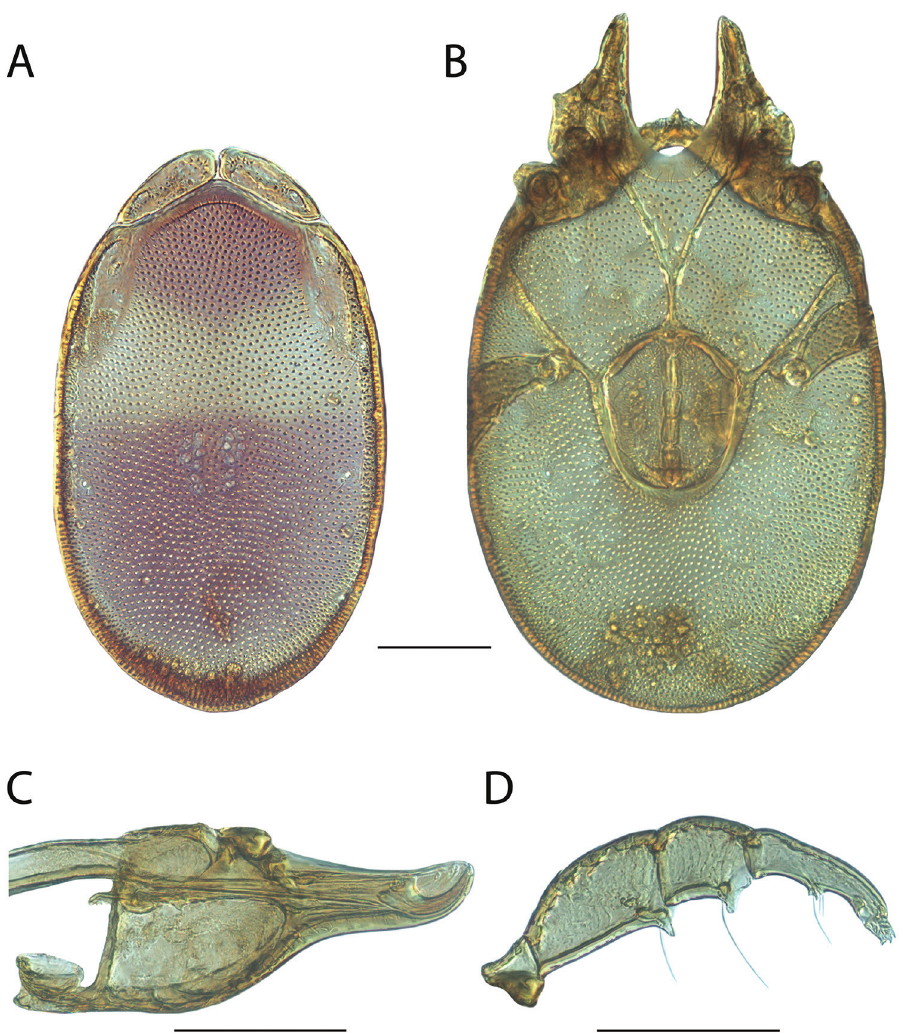
Figure 144. Torrenticola microbiscutella sp. n. female: A dorsal plates B venter (legs removed) C subca- pitulum D pedipalp (setae not accurately depicted). Scale = 100